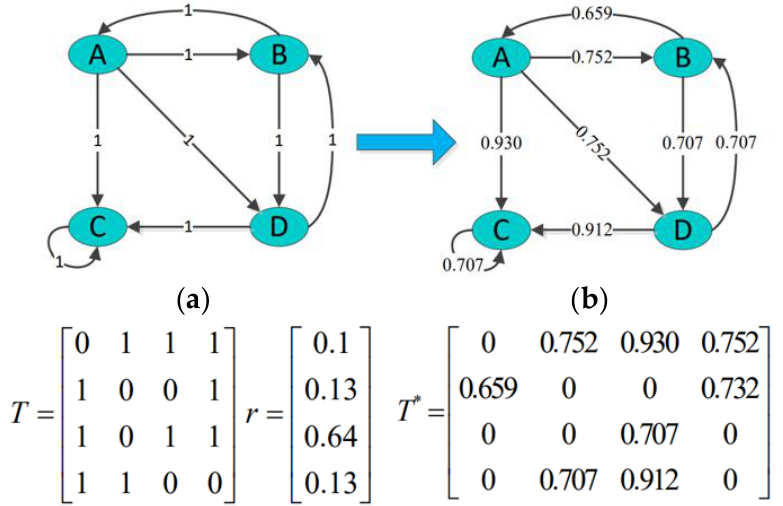
Figure 4. Quantification of trust network by TQ_RWR. ( a ) initial trust network; ( b ) reconstructed trust network.